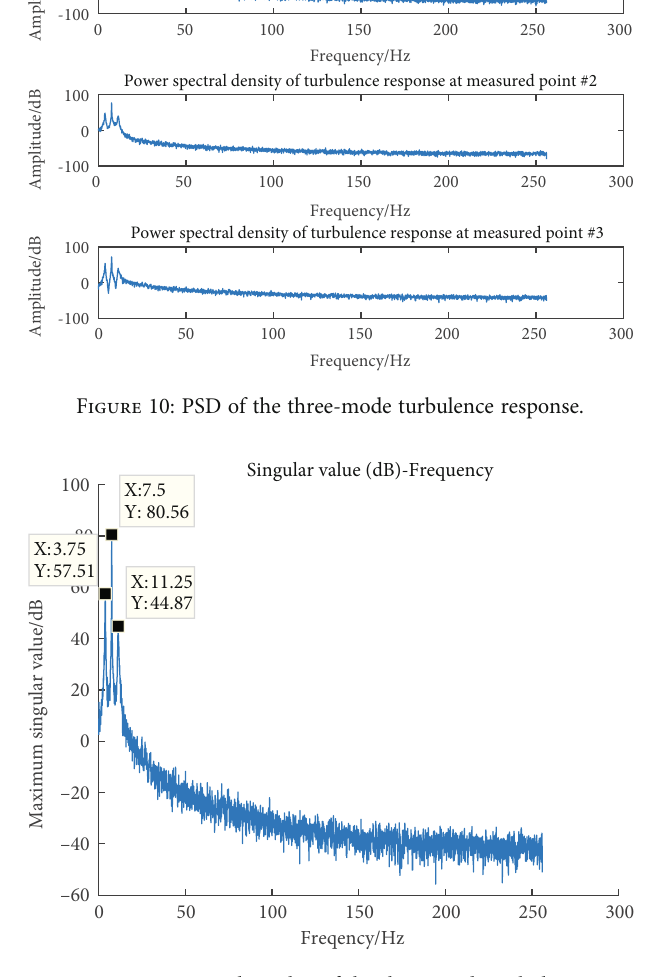
Figure 11: Maximum singular value of the three-mode turbulence response.